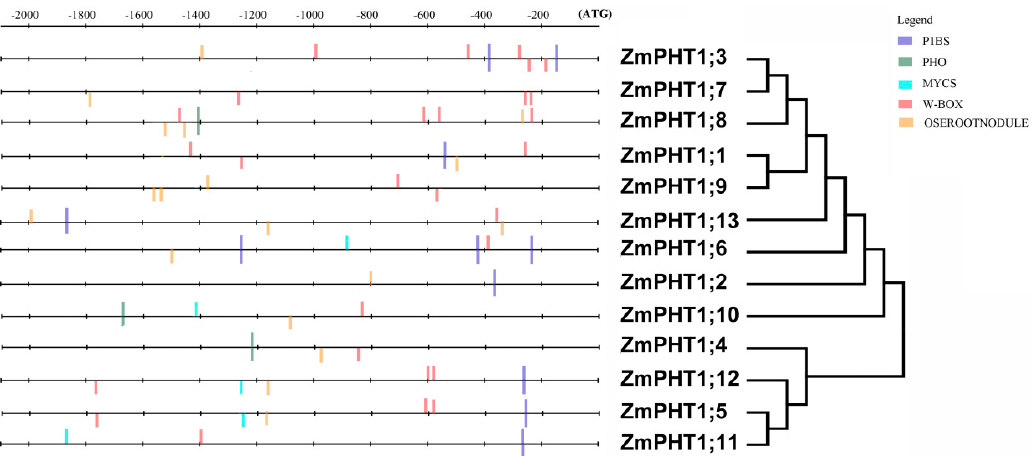
Figure 8. Analysis of regulatory elements in the promoters of ZmPHT1 genes. Three previously reported Pi-responsive motifs (P1BS, PHO and W-box) and two AM-activated motif (MYCS and OSEROOTNODULE) were searched by DNA-pattern matching arithmetic. PHO (CACGTG), P1BS (GNATATNC), W-BOX (TTGACY), MYCS (TTTCTTGTTCT, or with one nucleotide variation), OSEROOTNODULE (AAAGAT).